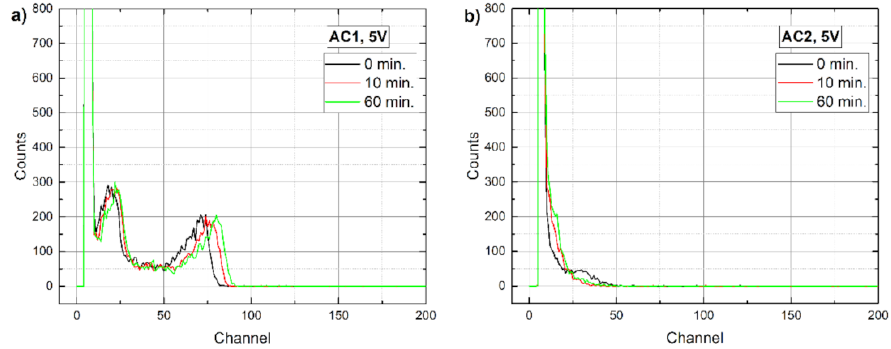
Figure 8. Time evolution of Am 241 spectra measured at 5 V on ( a ) AC1 and ( b ) AC2